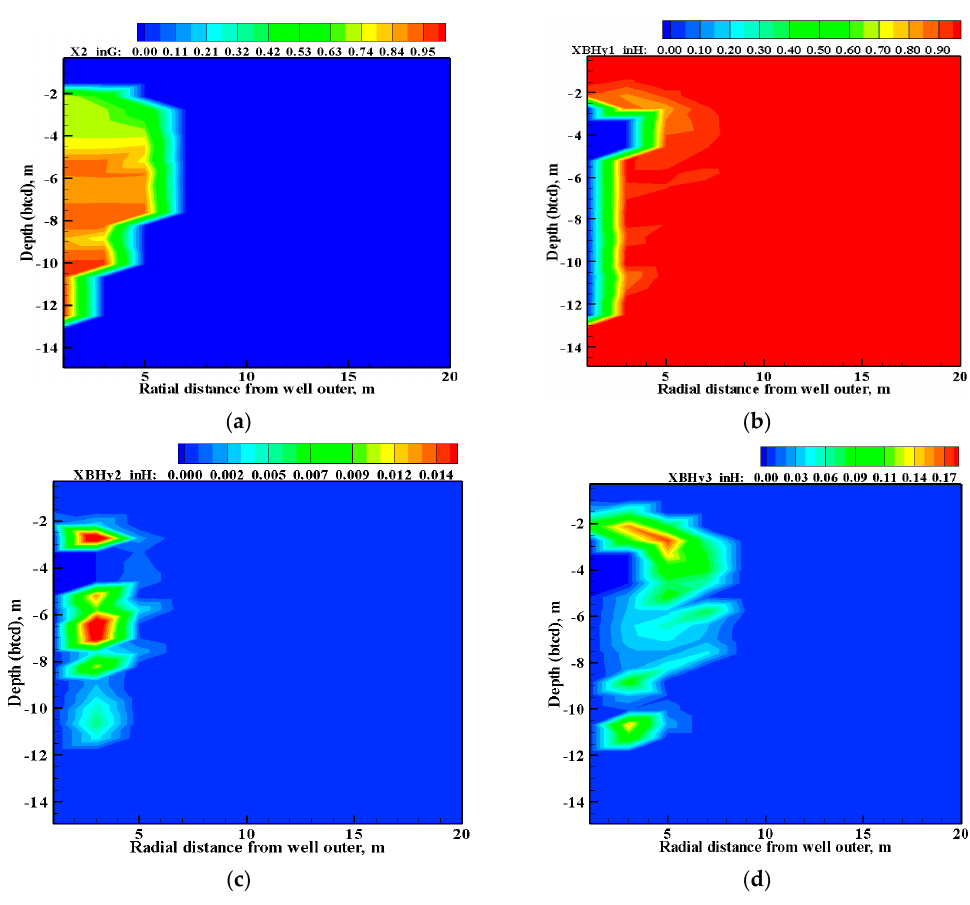
Figure 11. Mass fractions at the end of production. ( a ) Gas CH 4 in the gas phase; ( b ) CH 4 hydrate in the hydrate phase; ( c ) CO 2 hydrate in the hydrate phase; ( d ) N 2 hydrate in the hydrate phase.